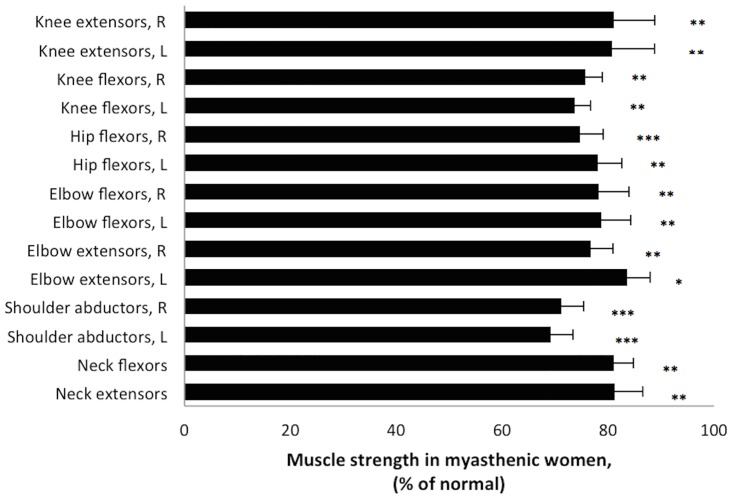
Muscle strength in women with generalized myasthenia gravis.Muscle strength in eight muscle groups in myasthenic women assessed by hand-held dynamometry, expressed as percentage of mean normative values (corresponding to 100%). L = left side and R = right side. * = p<0.05, ** = p<0.005 and *** = p<0.0001.